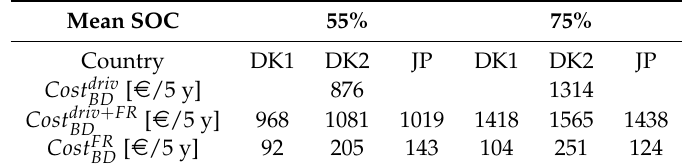
, Cost driv + FR and Cost FR for 5 years period of battery usage. BD BD BD